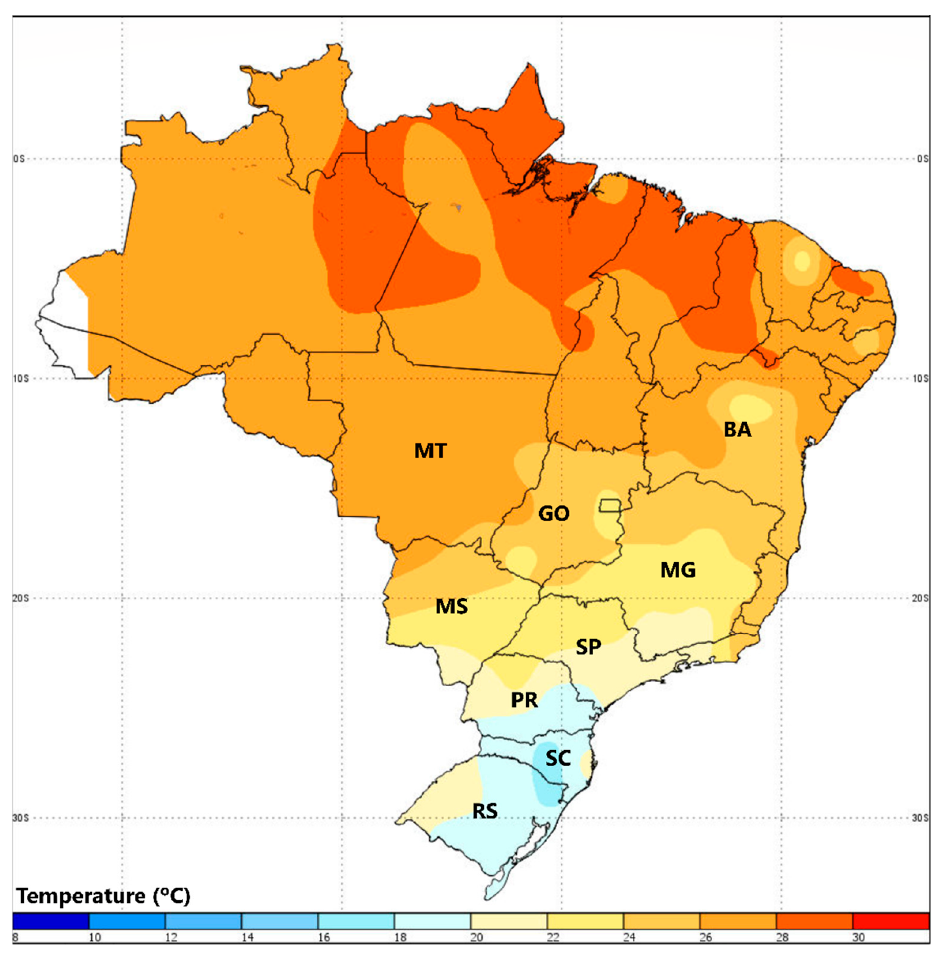
Figure 5. Mean annual temperature in Brazil from 1991 to 2020. Source: URL: https://clima.inmet.gov.br/NormaisClimatologicas/1961-1990/precipitacao_acumulada_mensal_anual, accessed on 10 November